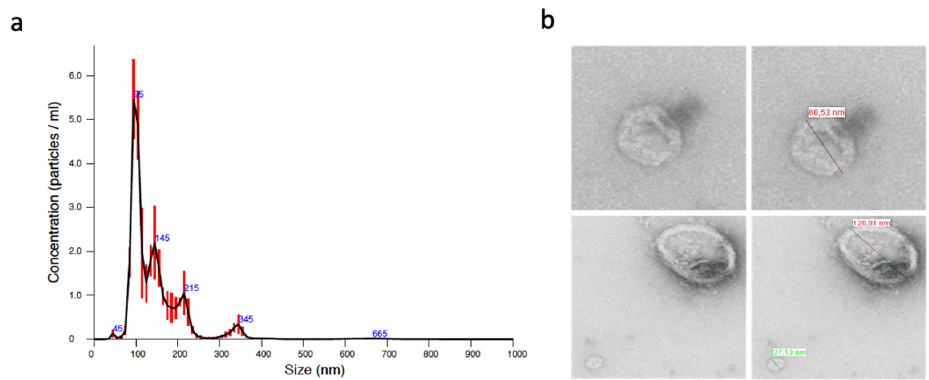
Figure 4. Characterization of EVs obtained by ultracentrifugation by ( a ) nanoparticle tracking analysis and ( b ) transmission electron microscopy. In the top right picture, a 60.53 nm vesicle is shown, and in the lower right picture, 126.81 nm and 27.13 nm vesicles are shown.